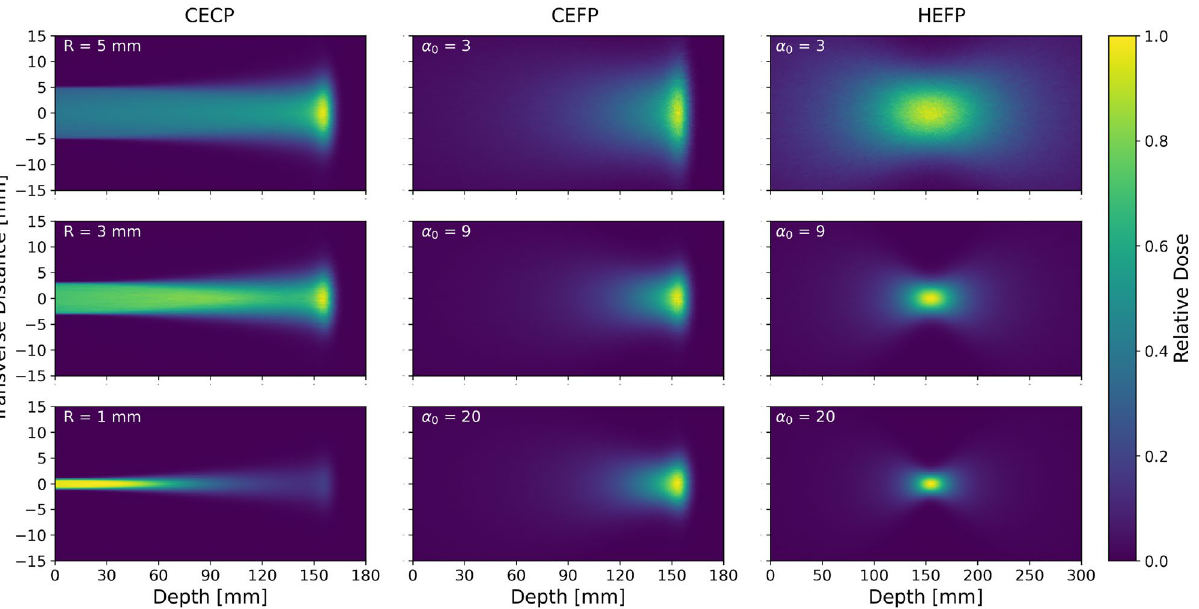
Figure 3. Simulated 2D dose profile for CECP (left column), CEFP (middle) and HEFP (right) beams. CECP and CEFP beam energy is 150 MeV, HEFP 350 MeV. Rows have different beam parameters, either collimator radius R or Twiss parameter α 0 . Please note that the maximum depth of the HEFP column is greater than for the CECP and CEFP columns.